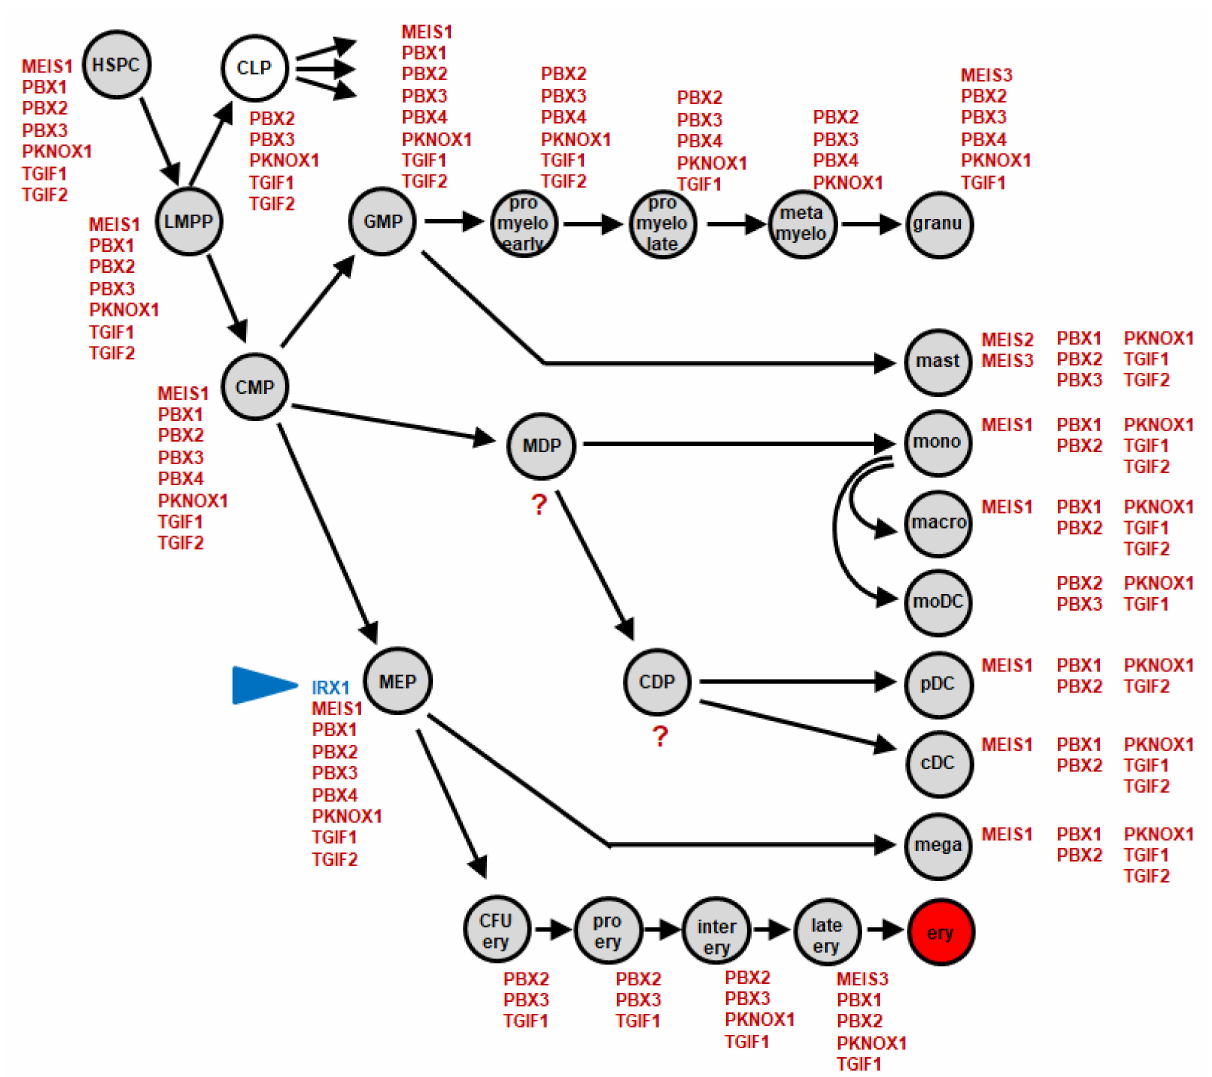
Figure 1. Myeloid TALE-code. This diagram summarizes the screening results for expression analy- ses of TALE homeobox genes (red) in early hematopoiesis and myelopoiesis. We have termed this expression pattern myeloid TALE-code. Expression of IRX1 is highlighted in blue (arrowhead). Ab- breviations: cDC, conventional dendritic cell; CDP, common dendritic progenitor; CFU ery, erythroid colony forming unit; CLP, common lymphoid progenitor; CMP, common myeloid progenitor; ery, erythrocyte; GMP, granulo-myeloid progenitor; granu, granulocyte; HSPC, hematopoietic stem and progenitor cell; inter ery, intermediate stage erythroblast; late ery, pyknotio-stage erythroblast; LMPP, lymphomyelo-primed progenitor; macro, macrophage; mast, mast cell; MDP, monocyte dendritic cell progenitor; mega, megakaryocyte; MEP, megakaryocytic-erythroid progenitor; metamyelo, metamye- locyte; moDC, monocyte-derived dendritic cell; mono, monocyte; pDC, plasmacytoid dendritic cell; pro ery, pro-erythroblast; pro myelo early/late, early/late